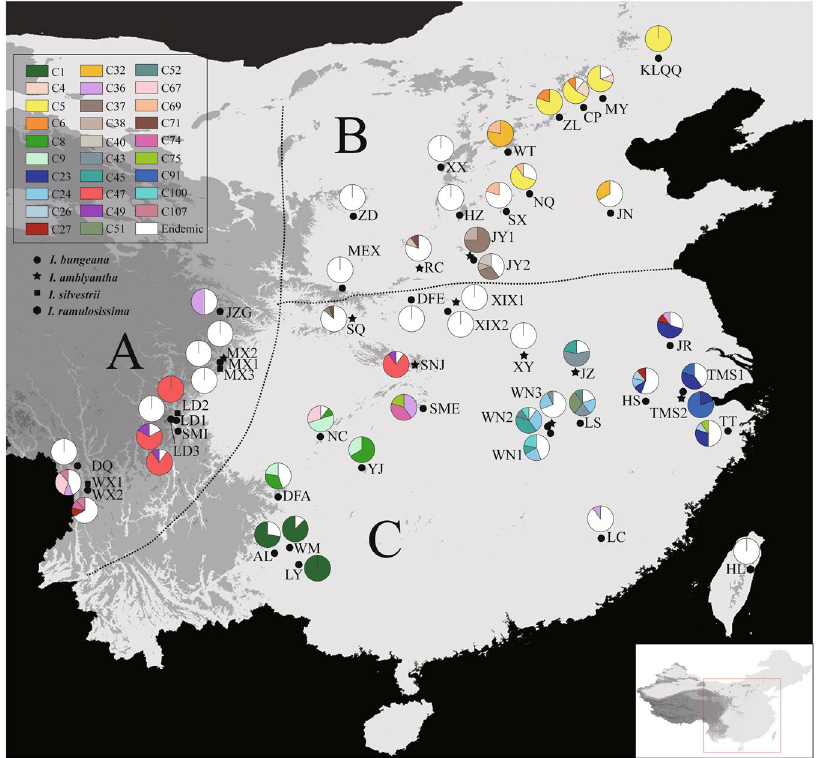
Figure 1. Geographic distribution of cpDNA haplotypes detected in Indigofera bungeana complex. The haplotypes found in more than one population are color-coded, while private haplotype particular to each population are shown in white. Figure was generated in DIVA-GIS 7.5